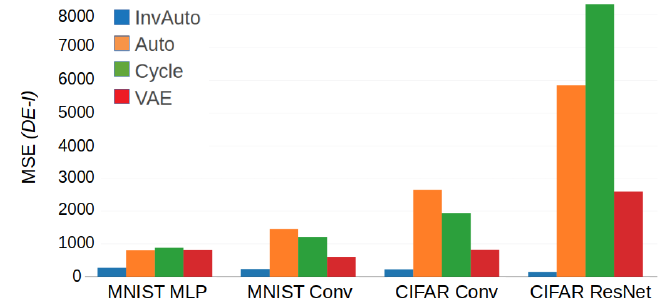
Figure 2. Comparison of the mean squared error (MSE) MSE ( DE − I ) for InvAuto, Auto, Cycle, and VAE on MLP, convolutional, and ResNet architectures and MNIST and CIFAR datasets. Matrices E and D are constructed by multiplying the weight matrices of consecutive layers of encoder and decoder,